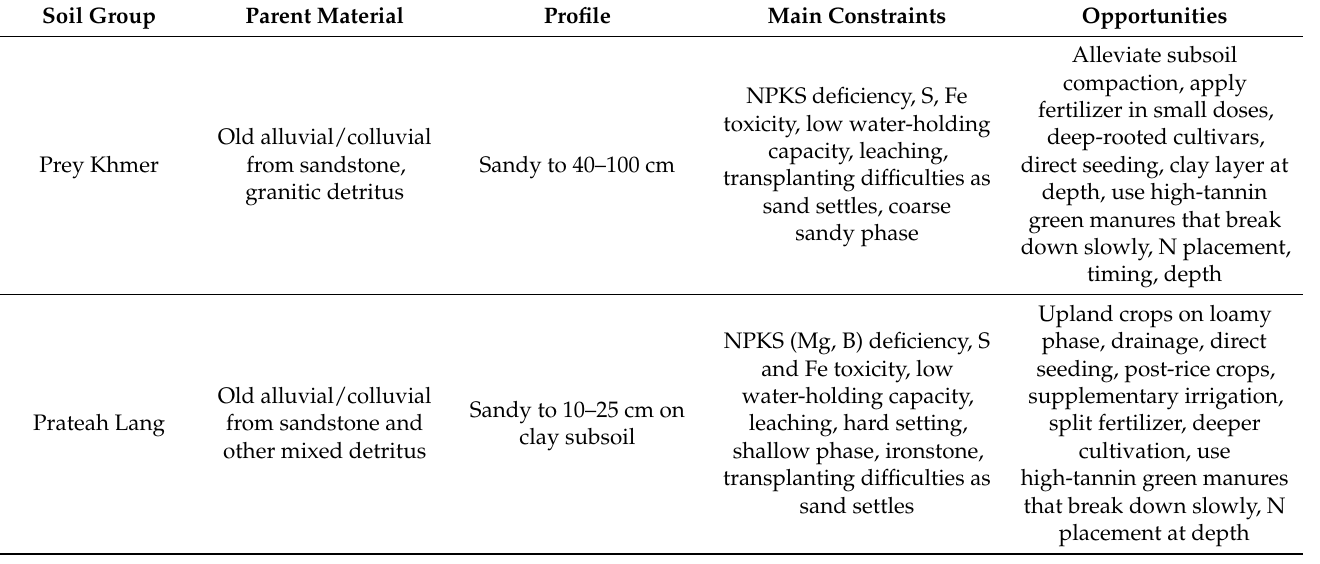
Table 4. Rice soils of Cambodia—constraints and opportunities for the growth of rice (after [4]).